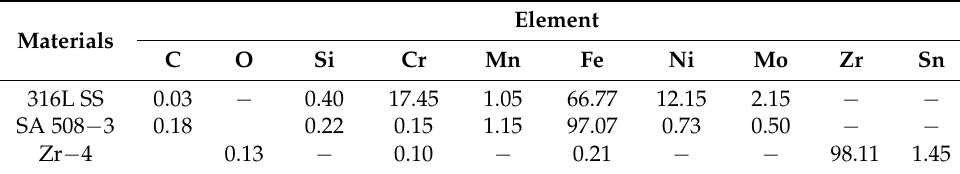
Table 1. Chemical composition of 316L SS, SA508 − 3 l and Zr−4 (wt.%).